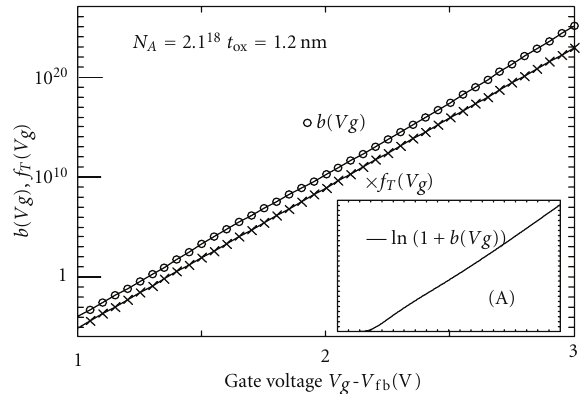
Figure 5: b ( Vg ) from (18) ( (cid:3)(cid:3) ) and f T ( Vg ) = exp( Vg − V T /η 0 U T )( ×× ). (A):[ln(1 + b ( Vg )), Vg ]